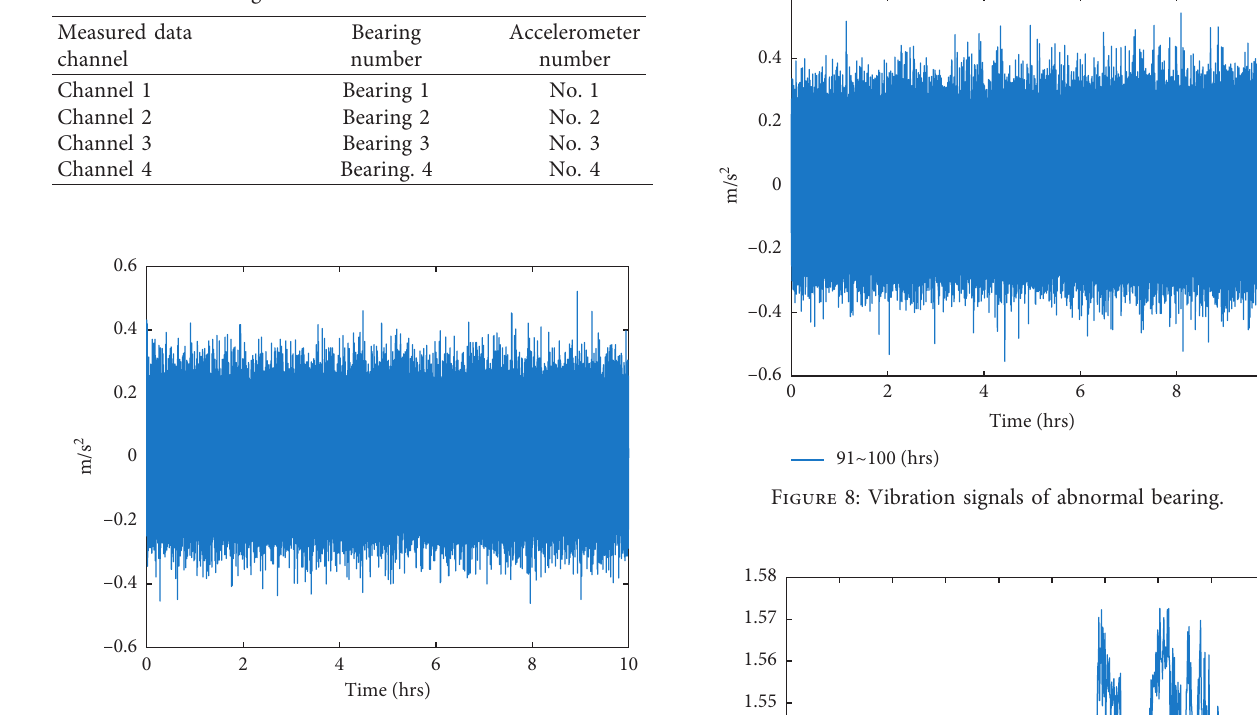
Figure 6: Experimental platform and accelerometer arrangement plan [33]. Table 1: Bearing number and accelerometer number.